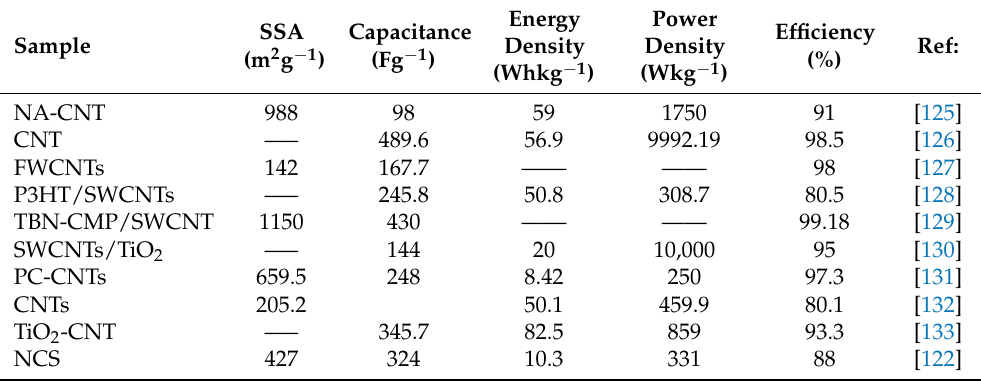
Table 3. The electrochemical performance characteristics of carbon nanotube electrodes.